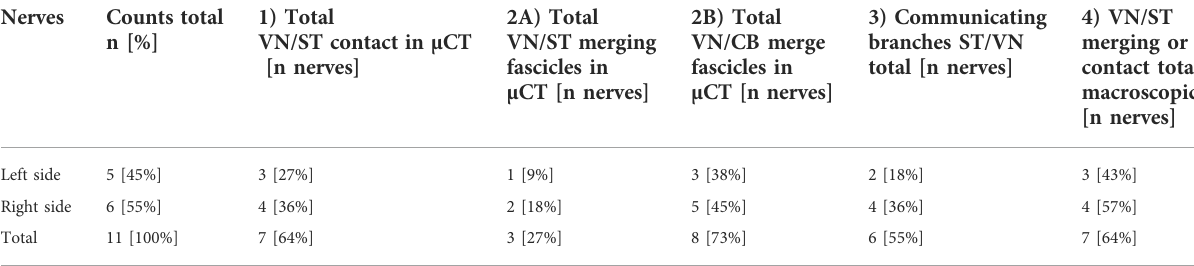
TABLE 1 Overview of the branching and merging patterns between VN, ST, and CB in µCT data of pig nerves. Numbers are presented as absolute and relativevalues.The fi rstpattern, “ contact ” ,withepineuriumbetweenVNandSTisdepictedincolumn1).Thesecondpattern “ mergingfascicles ” is representedincolumns2Aand2Bandpresentsthenumbersofnerves,inwhichmergingoffasciclesbetweentheVNandtheST(column2A),andthe VN and the CB (column 2B), respectively, occurred. Column3 represents the third pattern “ communicating branches between STand VN ” , which are cross-connections between these two nerves that were found in both preparations at the cervical level, the macroscopic dissections, and µCT data. Column 4 depicts the number of observations during dissections, where the VN and the ST nerves were showed either close contact or merging interactions ( “ merging or contact ” ) with each other in-situ .VN, Vagus Nerve; CB, cardiac branch; ST, Sympathetic trunk.